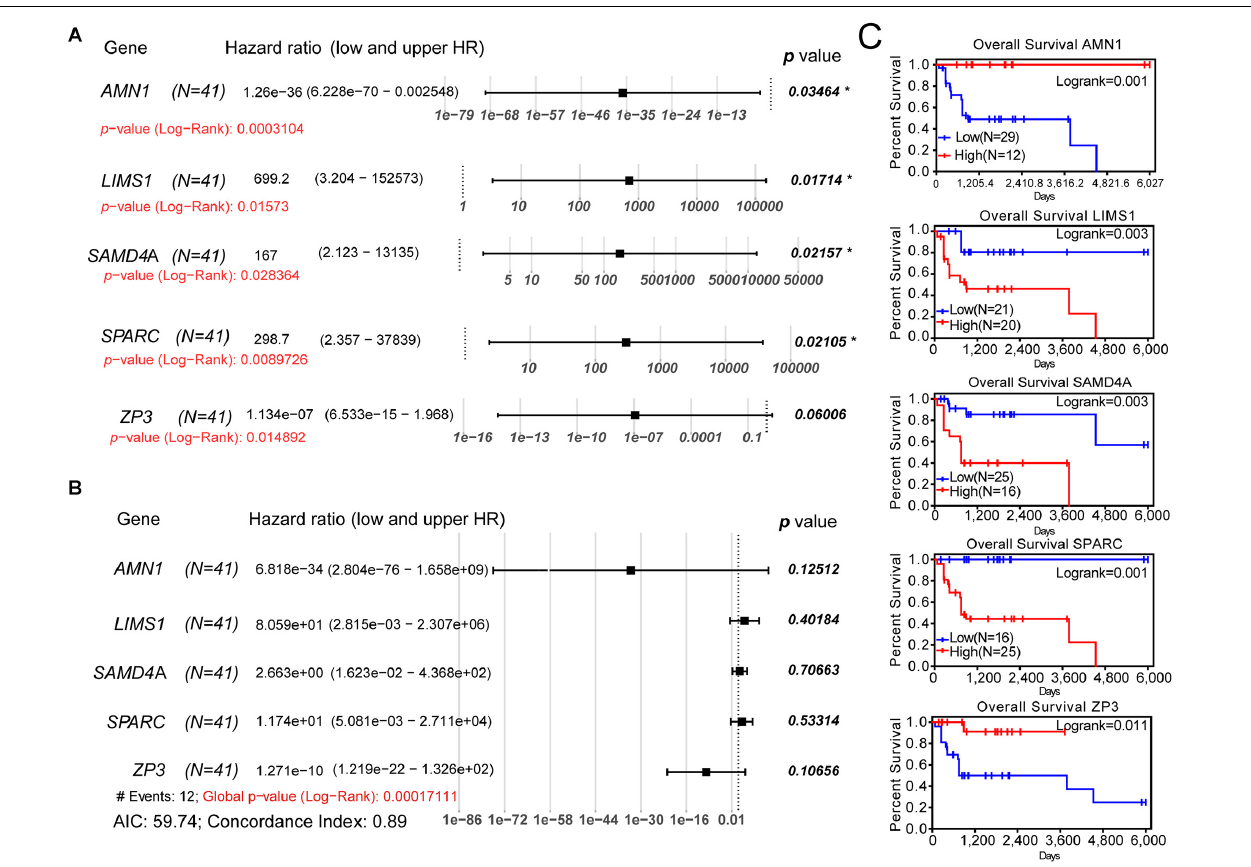
FIGURE 3 | Univariate and multivariate Cox regression analyses and K–M survival analysis of the five-gene prognostic model. (A) Univariate Cox regression analysis of each gene of the model. (B) Multivariate Cox regression analysis of the five-gene model. (C) K–M survival curves showing the difference in OS between the relative high- and low-expression groups for each gene according to the median of expression levels. K–M, Kaplan–Meier; AIC, Akaike information criterion; OS, overall